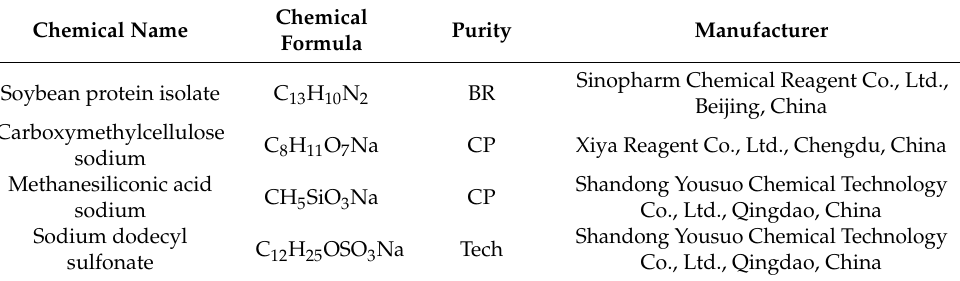
Table 1. Primary raw materials used in the experiment.